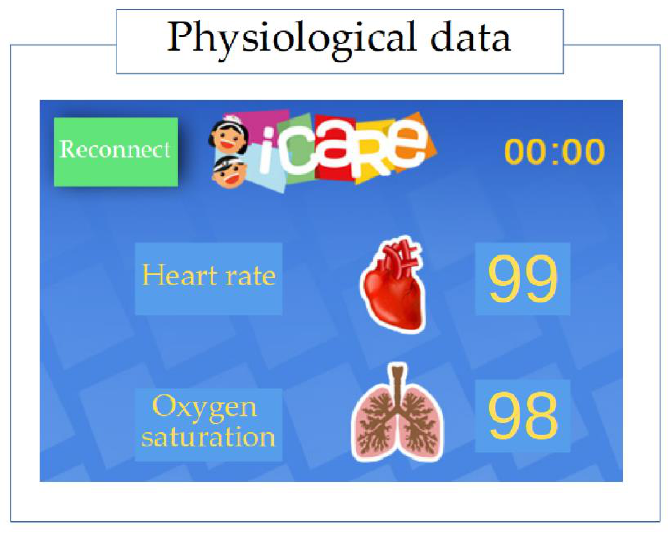
Figure 3. Physiological data shown on i-CARE.